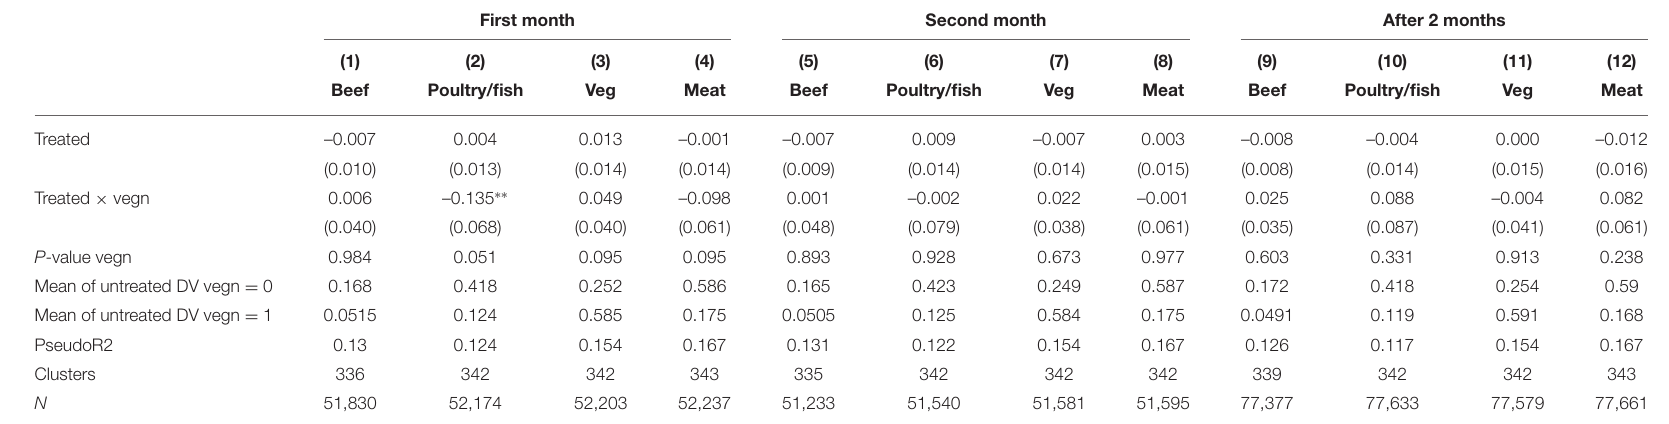
TABLE 4 | Heterogeneous effects by veg